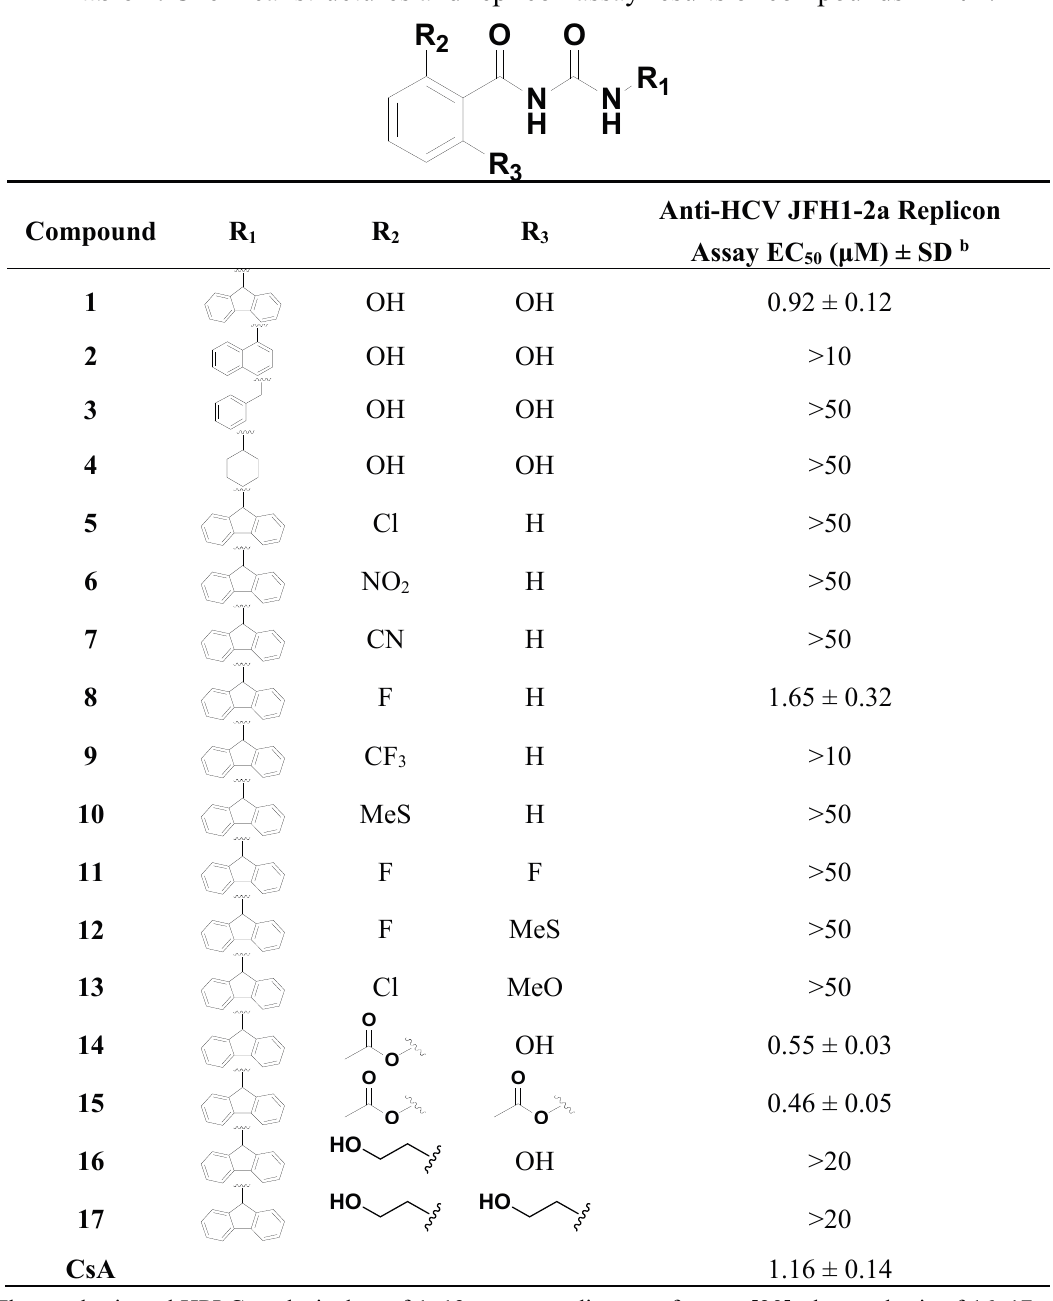
Table 1. Chemical structures and replicon assay results of compounds 1 – 17 a